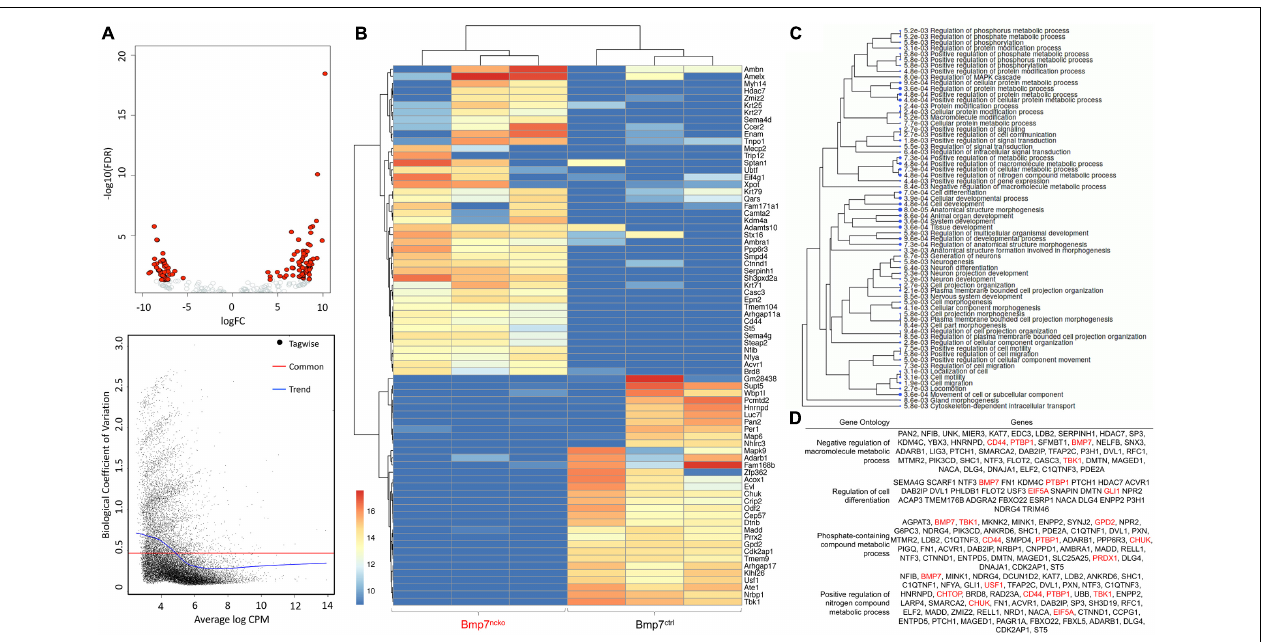
FIGURE 6 | RNA Sequencing analysis of P0 Bmp7 ctrl and Bmp7 ncko mice demonstrating differentially expressed genes ( n = 3/genotype). (A) Volcano plot demonstrating genes differentially upregulated and downregulated. Additionally, the biological coefficient of variation plot indicating biological variation within the samples to be between 0.4 and 0.5. (B) Heat-map outlining differentially expressed genes between Bmp7 ctrl and Bmp7 ncko mice. (C) Gene ontology (GO) terms of genes identified to be differentially expressed. (D) Specific GO terms and their associated genes. Altered metabolic was a prominent GO term identified in the RNASeq analysis. Genes in red have been validated using qRT-PCR ( Figure 7